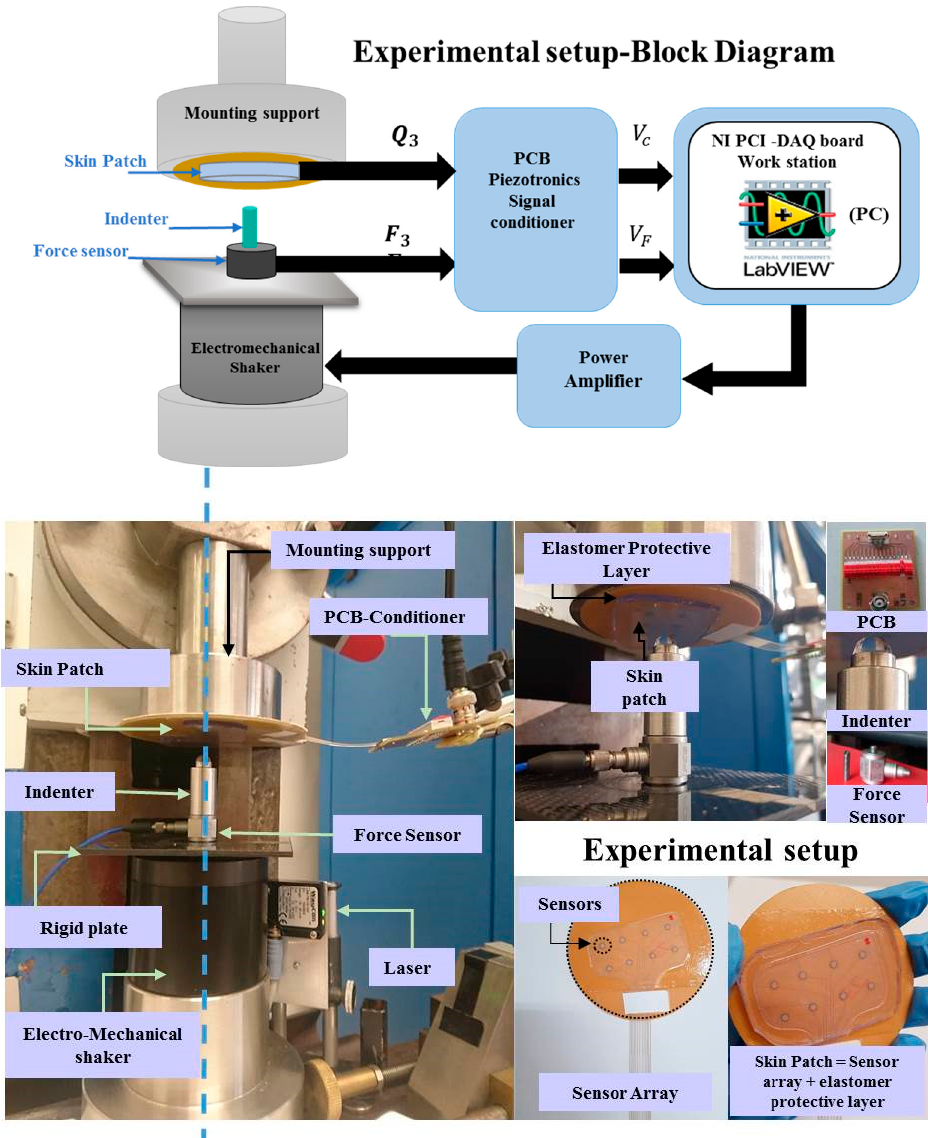
Figure 4. Experimental setup. Top: Block Diagram, Bottom: Pictures of the setup. The blue dotted line shows the alignment of the testing elements.